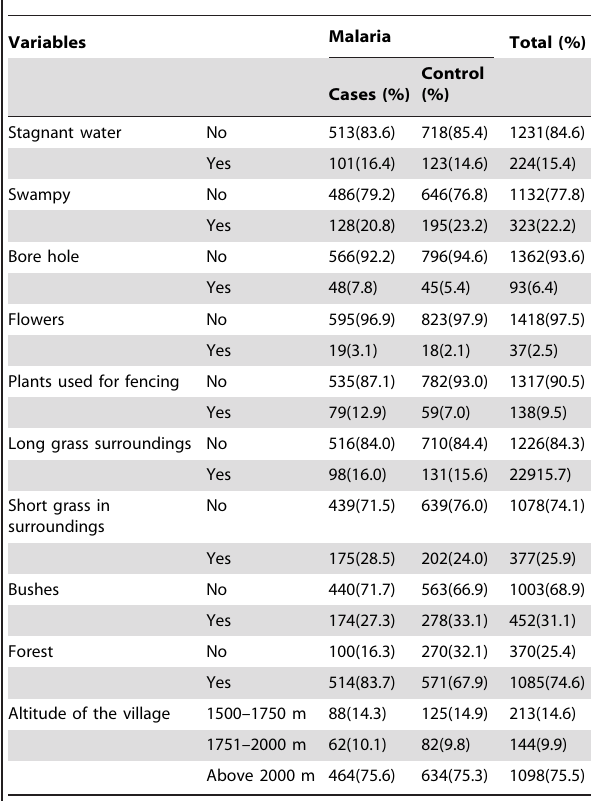
Table 2. Characteristics of homestead environment and travel history in high altitude villages of northwest Ethiopia, 2013.